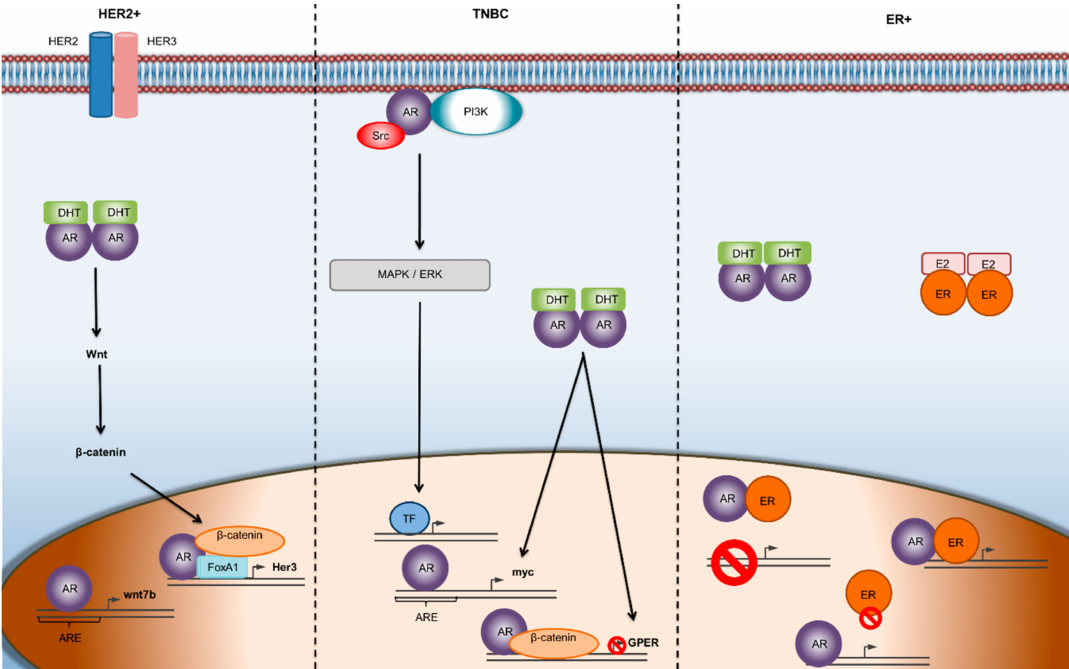
Figure 1. Mechanisms of AR mediated gene transcription in di ff erent subtypes of breast cancer. In ER- α -negative / HER 2-positive breast cancer, the Wnt / β -catenin pathway is implicated and facilitates the transcriptional activity of AR promoting tumor growth. In TNBC, androgens seem to initiate second- messenger signaling cascades, which often results in a feedback loop, leading to the progression of the tumor. In the ER-positive, BC subtype, there is a dynamic relationship between ER and AR, where the two receptors can transcriptionally regulate each other through heterodimerization and binding to the same DNA sequence. Abbreviations: AR—androgen receptor; ARE—androgen receptor